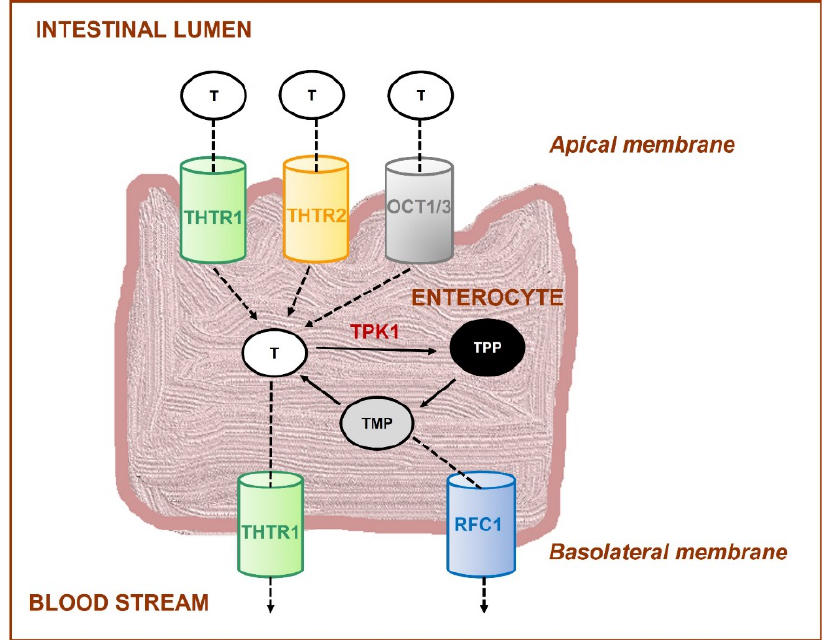
Figure 2. Intestinal uptake of thiamine. THTR1 carrier (encoded by SLC19A2 gene); THTR2 carrier (encoded by SLC19A3 gene); OCT1/3, organic cation-transporter 1/3; RFC1, reduced folate carrier (encoded by SLC19A1 gene); T, thiamine; TMP, thiamine monophosphate; TPP, thiamine pyrophosphate; TPK1, thiamine phosphokinase. The concentrations of total thiamine (free thiamine and its phosphorylated forms) in whole blood are in the range of 75–200 nmol/L. Once in the circulation, thiamine crosses the erythrocyte membrane by the means of THTR1 and THTR2 transporters. In the TMP transport, RFC1 is again implicated. Inside the red blood cell, phosphorylation occurs and TPP is formed. The result is that 80% of thiamine in the blood is located in erythrocytes in the form of TPP. Only low concentrations of the vitamin are present in the plasma, both as free thiamine, TMP and protein bound TPP [198,199]. From blood, thiamine is taken up into cells of various tissues by previously men- tioned transporters, i.e., THTR1, THTR2, and OCT, while RFC1 allows TMP transfer again (Figure 3). Both carriers THTR1 and THTR2 are highly expressed in the cells of various organs, e.g., skeletal muscle, heart, kidney, liver, pancreas, brain, placenta, and adipose tissue [5,200]. Within the cell, free thiamine is phosphorylated to thiamine pyrophosphate (TPP) by a specific cytosolic kinase, i.e., thiamine pyrophosphokinase (TPK1). The synthesis re- quires magnesium and adenosine triphosphate (ATP) [201]. TPP is the metabolically ac- tive form, which acts as a crucial cofactor in multiple enzymatic reactions in the cytosol (e.g., transketolase), in the mitochondria (see below and Figures 3 and 4) [202–204]. The transport of TPP into the mitochondria is mediated via the thiamine pyrophosphate car- rier (TPC) encoded by the SLC25A19 gene.